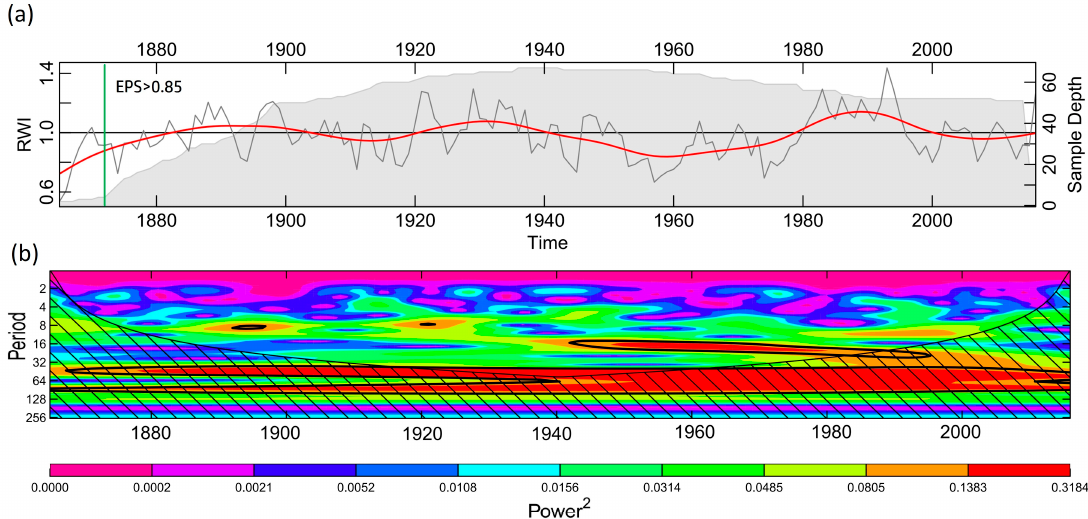
Table 4. Factor loadings of principal components from PCA of the TRW chronologies of the Ili River Basin.